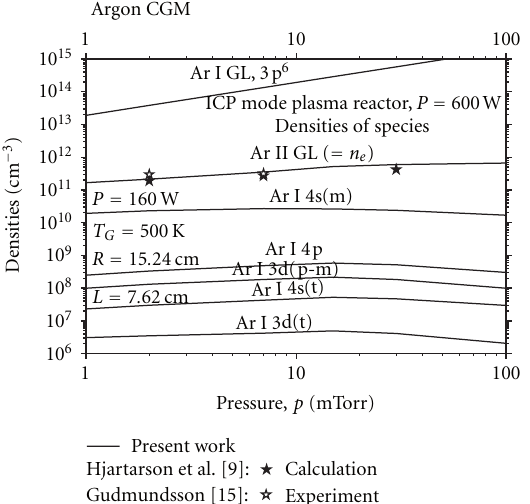
Figure 11: Calculated densities of species in the plasma reactor for 1mTorr < p < 100 mTorr. Comparison with values of Hjartarson et al. [9] and Kimura and Kasugai